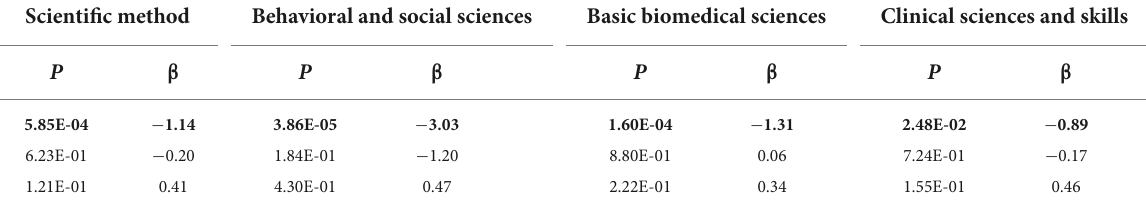
TABLE 1 Correlations between tridimensional personality questionnaire and academic